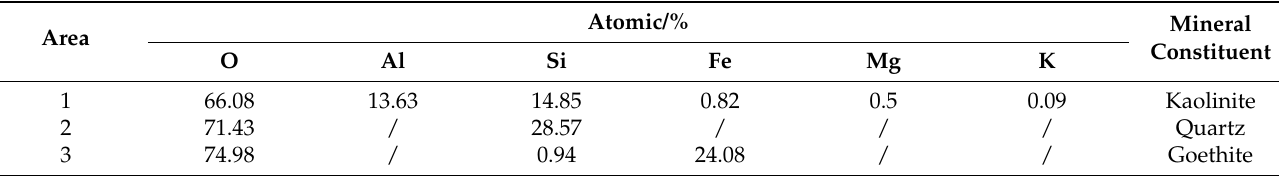
Table 5. EDS analysis results for areas in Figure 3.